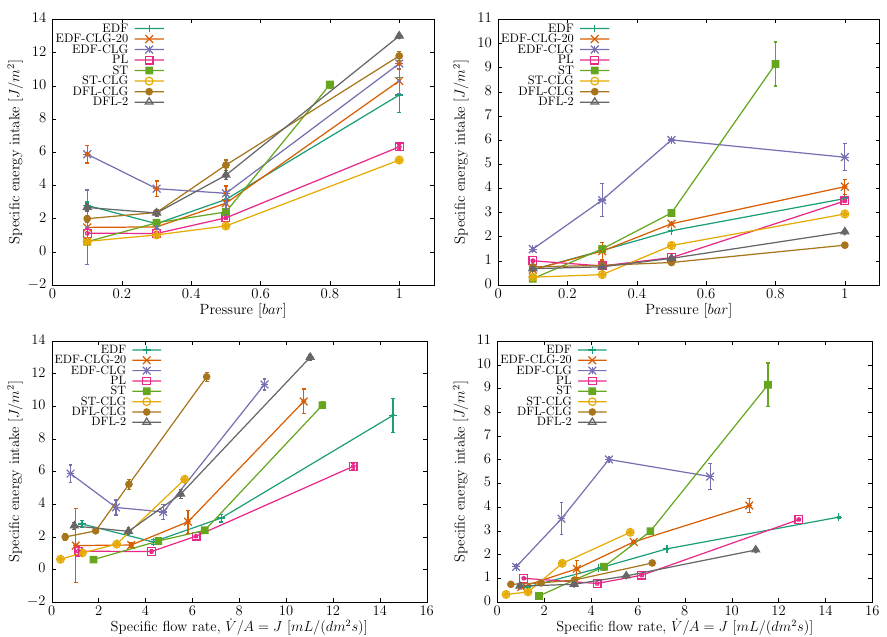
Figure 6. Specific energy intake versus applied pressure difference ( top row ) and versus specific flow rate ( bottom row ) for all cases, ( left )—valve opening, ( right )—valve